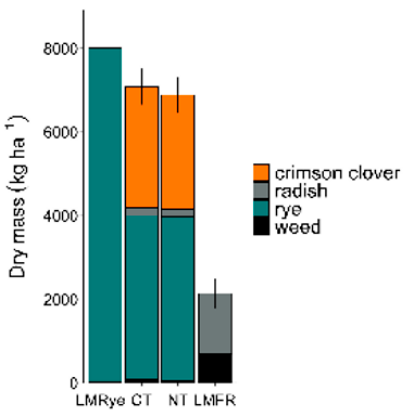
Figure 1. Mean biomass of cover crop and winter annual weeds averaged over all experiment years in plots designated as living mulch + rye (LMRye), conventional tillage (CT), no-till (NT), and living much + forage radish (LMFR).